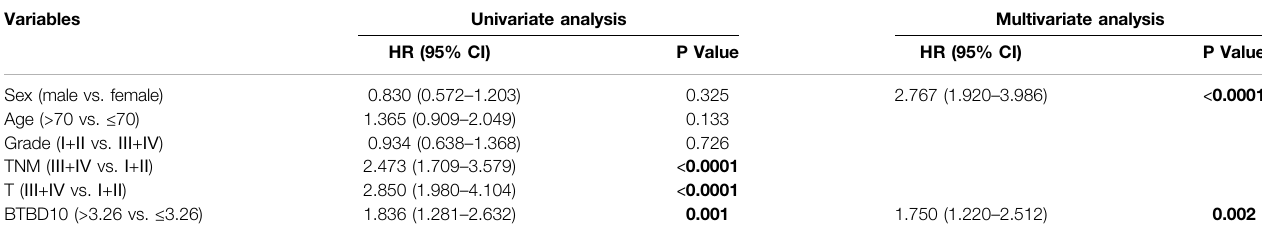
TABLE 2 | TCGA data: Univariate and multivariate cox regression analyses of risk factors associated with overall survival. Variables Univariate analysis Multivariate analysis HR (95% CI) P Value HR (95% CI) P Value Sex (male vs. female) < 0.0001 Age ( > 70 vs. ≤